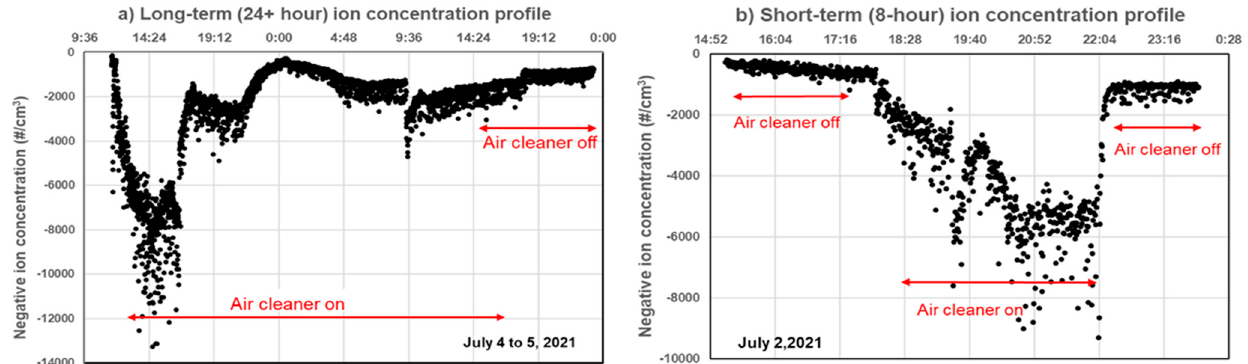
Figure 4. Example negative ion concentration profiles over time for ( a ) long-term (24+ h operation) test followed during ‘natural’ conditions (i.e., no pollutant injection) and ( b ) short-term (4-h operation) test during ‘natural’ conditions (i.e., no pollutant injection).